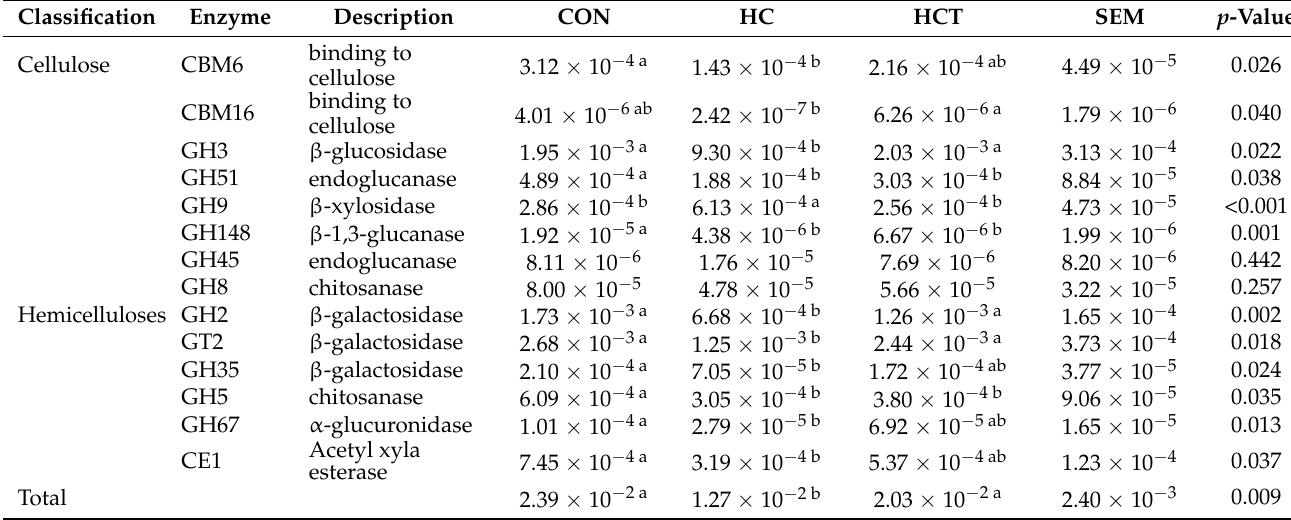
Table 2. Effects of high-concentrate diet and thiamine supplementation treatment on the relative abundance of genes that encoded fiber-degrading enzymes.